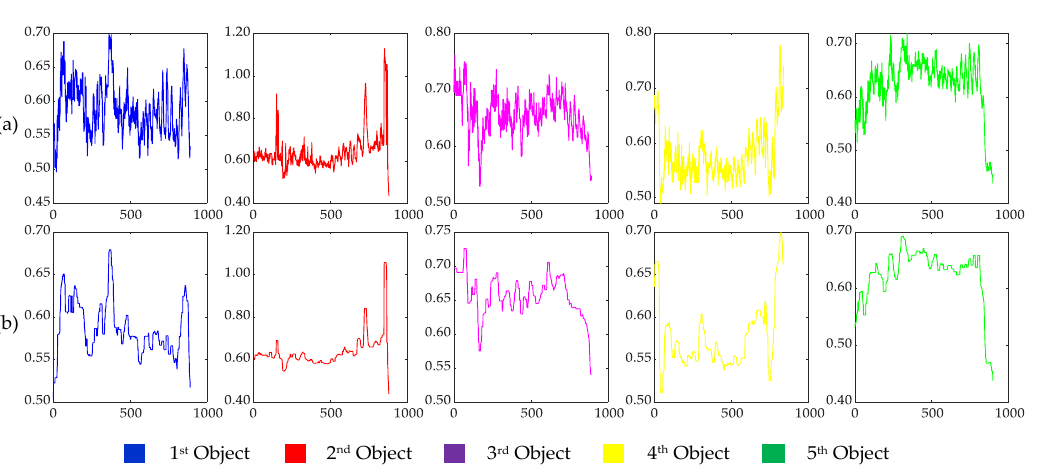
Figure 11. The width of moving objects. ( a ) The original calculation results of the object width; ( b ) the calculation results of the object width filtered by median filtering. The ordinate is the width (m), and the abscissa is the video frame